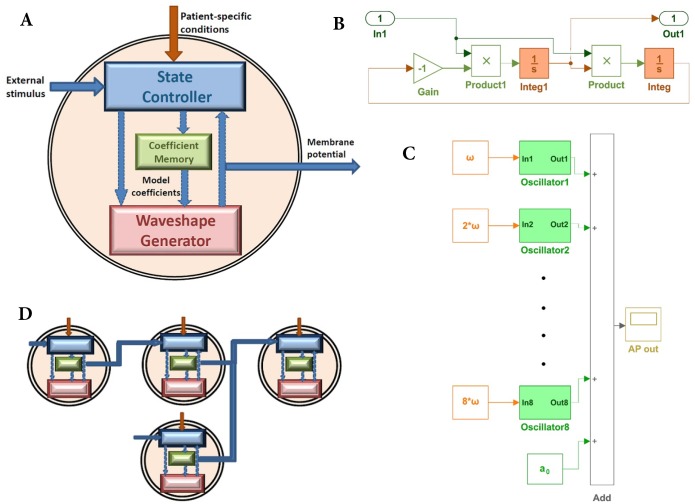
Resonant model of a biological cell.A: Schematic representation of a resonant model. B: An oscillator implemented with two integrators in series generating sine term and cosine term of the same frequency simultaneously. C: The waveshape generator implemented in SIMULINK with eight Fourier terms. D: Pictorial representation of the compositional property (series and parallel connections) of the RM cells.